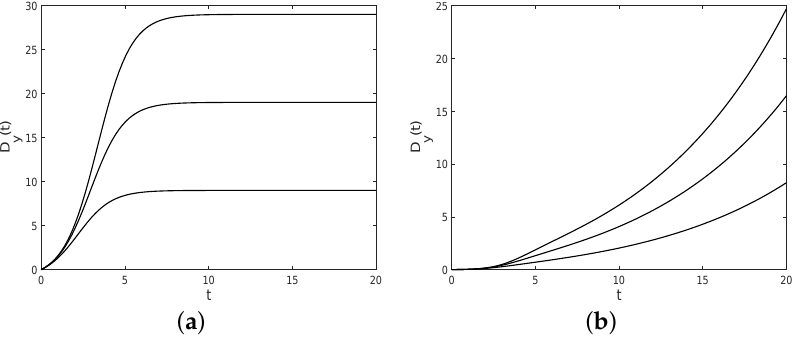
Figure 16. For y = 0.1, r = 1 and σ = 1/3, the Fano factor D y ( t ) is plotted for the birth process in ( a ) and for the diffusion process ˜ X ( t ) in ( b ) with C = 1,2,3 (from bottom to top).